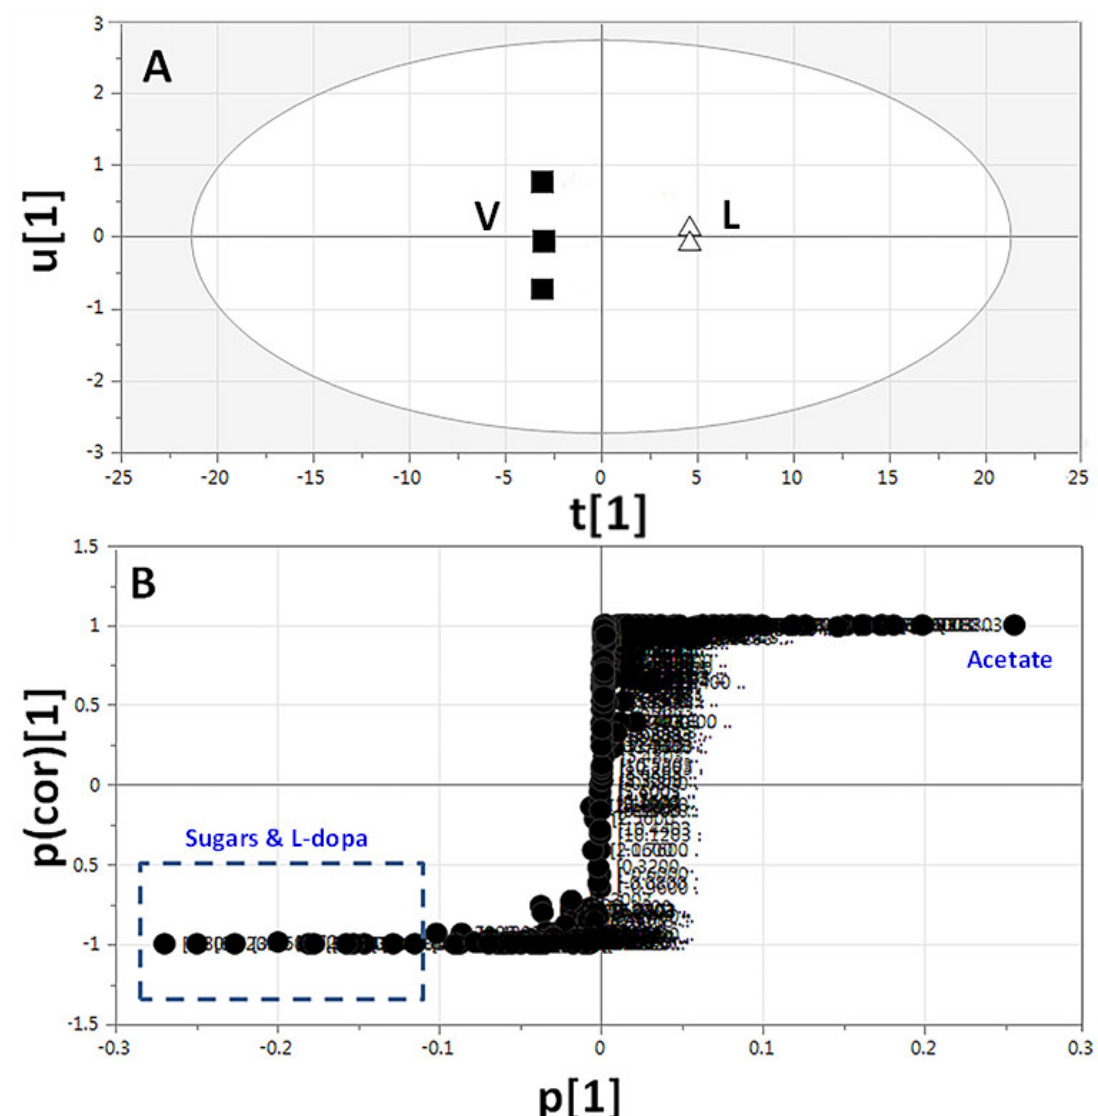
Figure 6. Orthogonal projection to latent structures-discriminant analysis (OPLS-DA) based on full-range 1 H-NMR (δ 11.0– 0.0 ppm) of Vicia sprouts ( ■ ) modelled against Lens sprouts (∆) ( n = 3). ( A ) OPLS-DA score plot and ( B ) loading plot derived from samples modelled against each other. The loading S-plot shows the covariance p[1] against the correlation p(cor)[1] of the variables of the discriminating component of the OPLS-DA model. Peak numbering follows those listed in Table 1 for metabolites identification using 1D- and 2D-NMR.